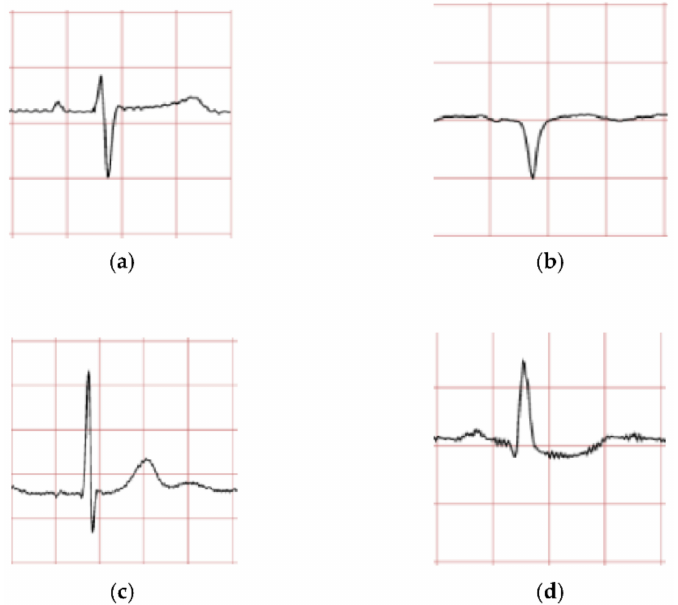
Figure 8. ECG data preprocessed: ( a ) normal sinus ECG waveform; ( b ) sudden death ECG waveform; ( c ) arrhythmia ECG waveform; ( d ) supraventricular arrhythmia ECG waveform.